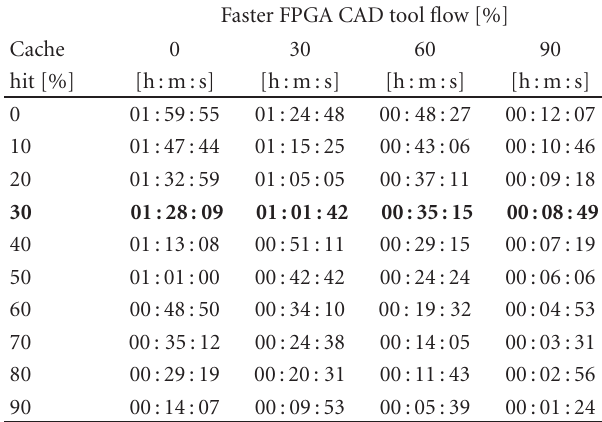
Table 8: The average breaking-even time for the embedded appli- cations using a partial reconfiguration bitstream cache and a faster FPGA CAD tool